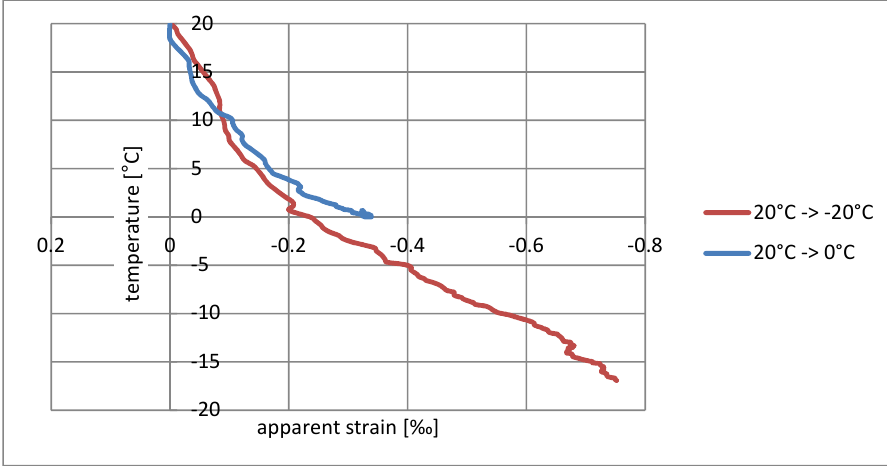
Figure 5. Dependence of apparent strain on decreasing temperature for the wooden sample.